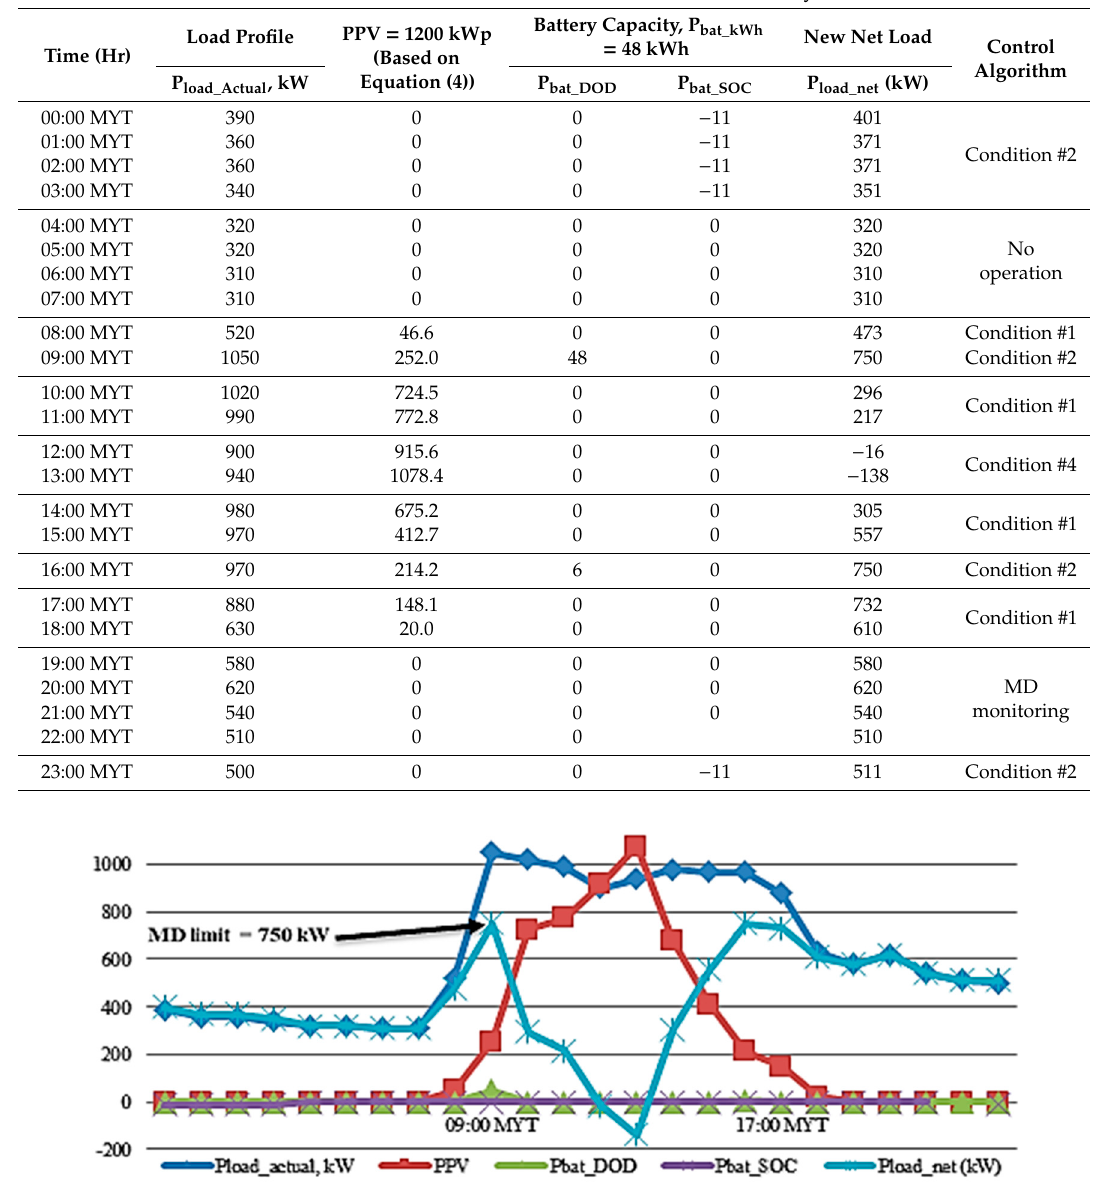
Figure 7. MDRed model validation graph (for Table 10 data.)